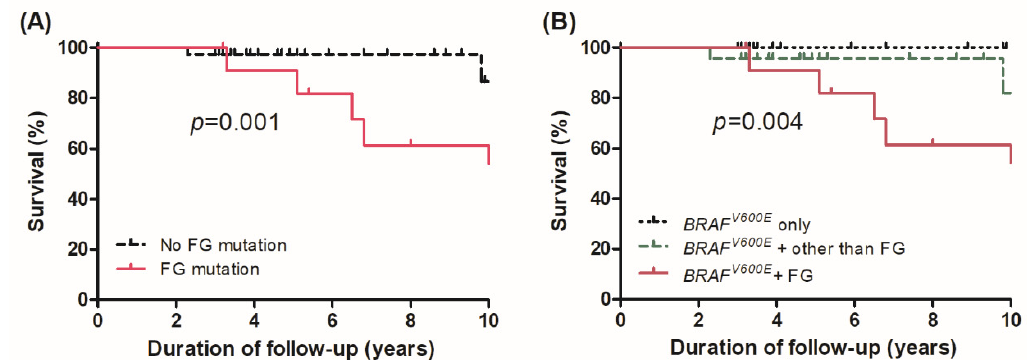
Figure 2. Overall survival curve ( A ) of patients with advanced PTC according to presence of mutations in functional groups and ( B ) among three genomic subgroups: BRAF V600E only (group 1) vs. BRAF V600E + additional mutations other than functional groups (group 2) vs. BRAF V600E + mutations in functional groups (group 3).